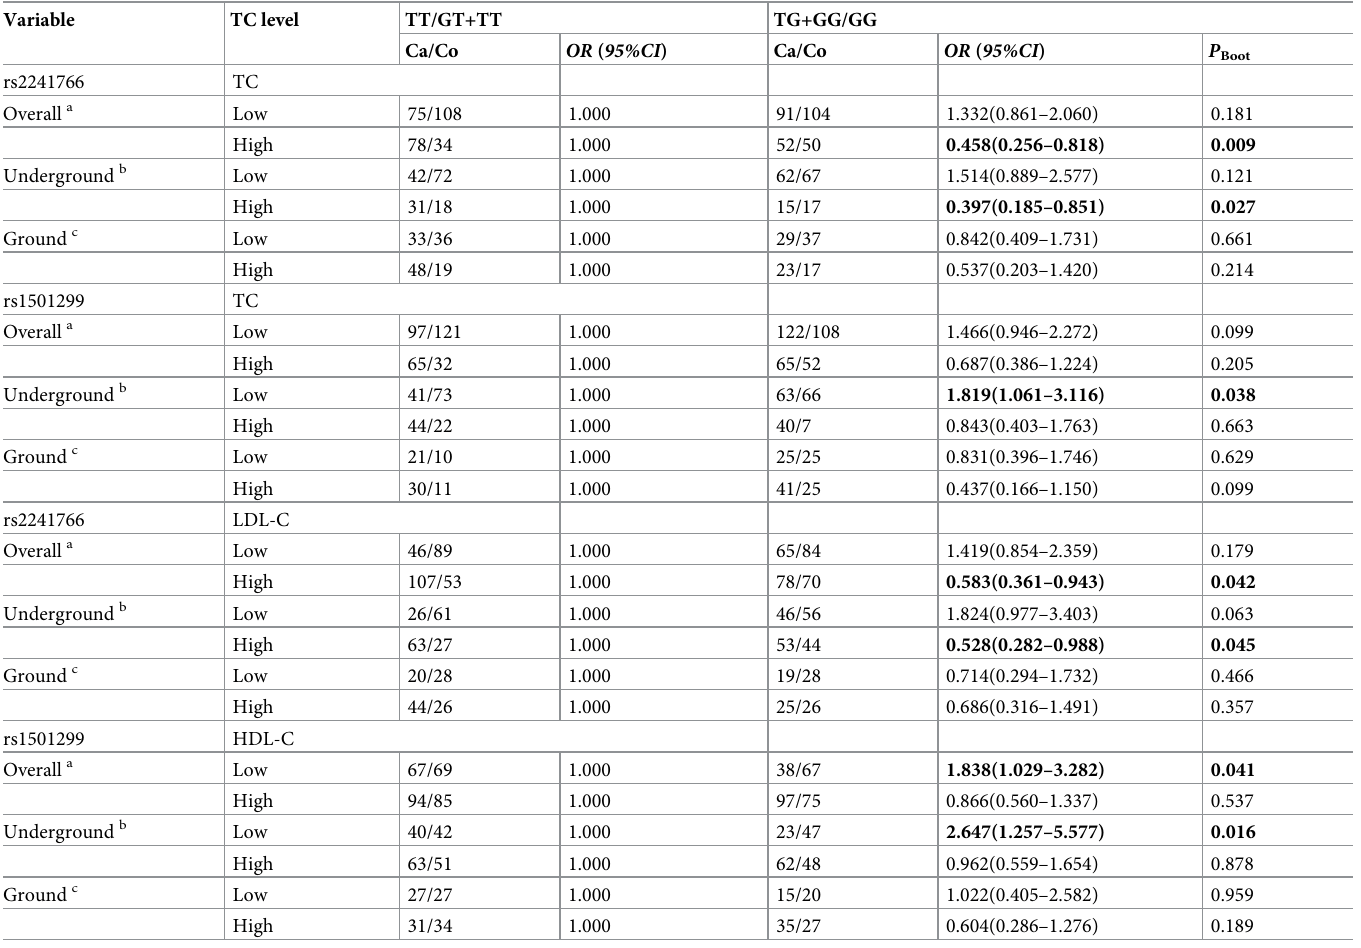
Table 6. Associations of hypertension risk with rs2241766 and rs150129 stratified by lipid